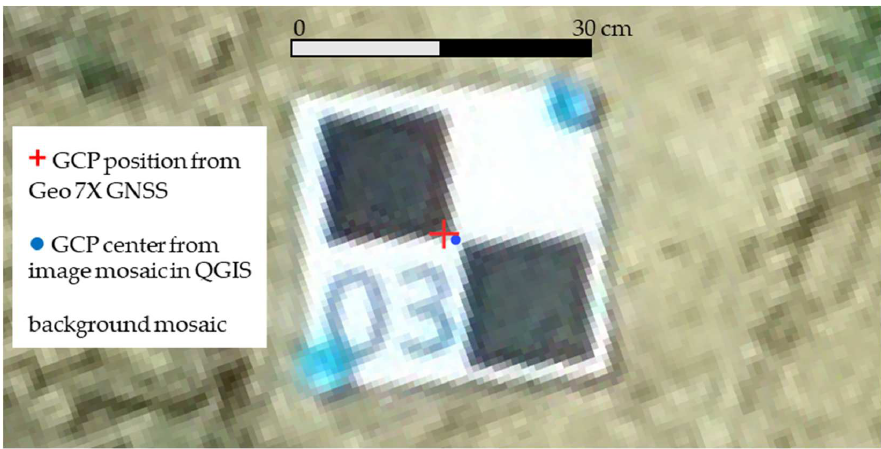
Figure 22. GCP center ( • ) manually digitized from the ortho-image in a points layer using QGIS. 2.9. Evaluation of the Accuracy of Maize Plant Position in Ortho-Mosaics For each UAV flight, the ortho-mosaic was displayed in QGIS and the position of the maize markers was digitized in a point layer. The digitized point was on the intersection